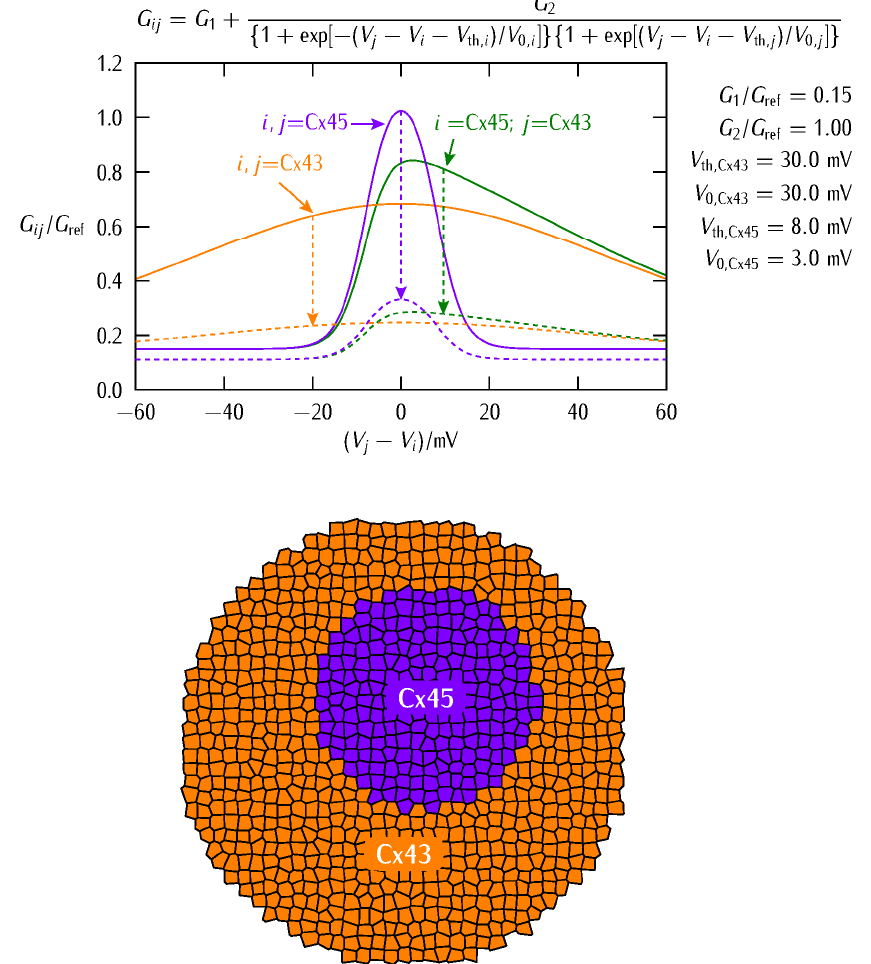
Figure 3. The gap junction conductances obtained from Equation (3) with the parameters shown in the figure ( top ). The symmetrical and asymmetrical cases of Figure 1 are considered together with the effect of decreasing the conductances G 1 and G 2 to the values G (cid:48) = 2 ( dashed lines ). This decrease may be due to an inhibition of the connexin expressions or the post-translational blocking of the junctions. The multicellular scheme shows the inner patch of n = 221 cells where connexin Cx45 is predominantly expressed surrounded by a bulk of N − n = 661 cells where connexin Cx43 is dominant ( bottom ), with N = 882 cells. Note that at the interface between the two cell regions with different homotypic gap junctions a heterotypic Cx43|Cx45 junction is formed.